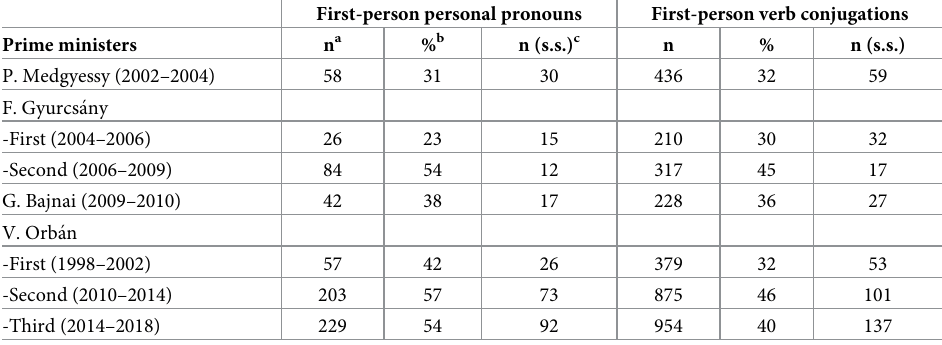
Data is shown for the four Hungarian PM from 1998 to 2018. a Number of items. b Percentage of